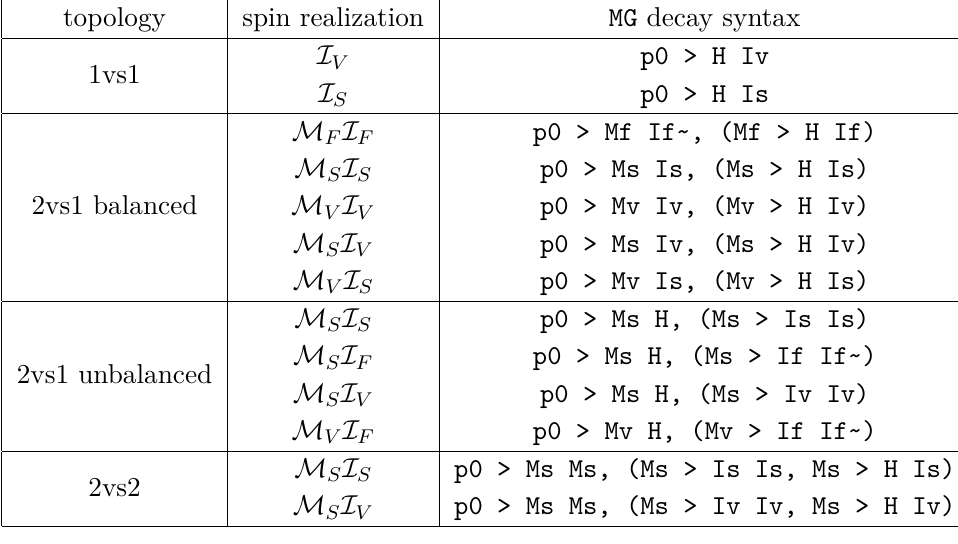
Table 2. List of mono-Higgs topologies with MadGraph syntax for event generation. The syntax for bottom-associated production